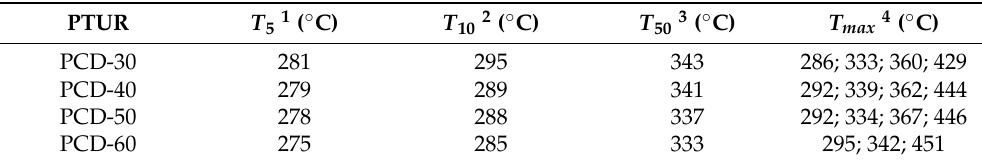
Table 5. TG data of the synthesized PTURs.